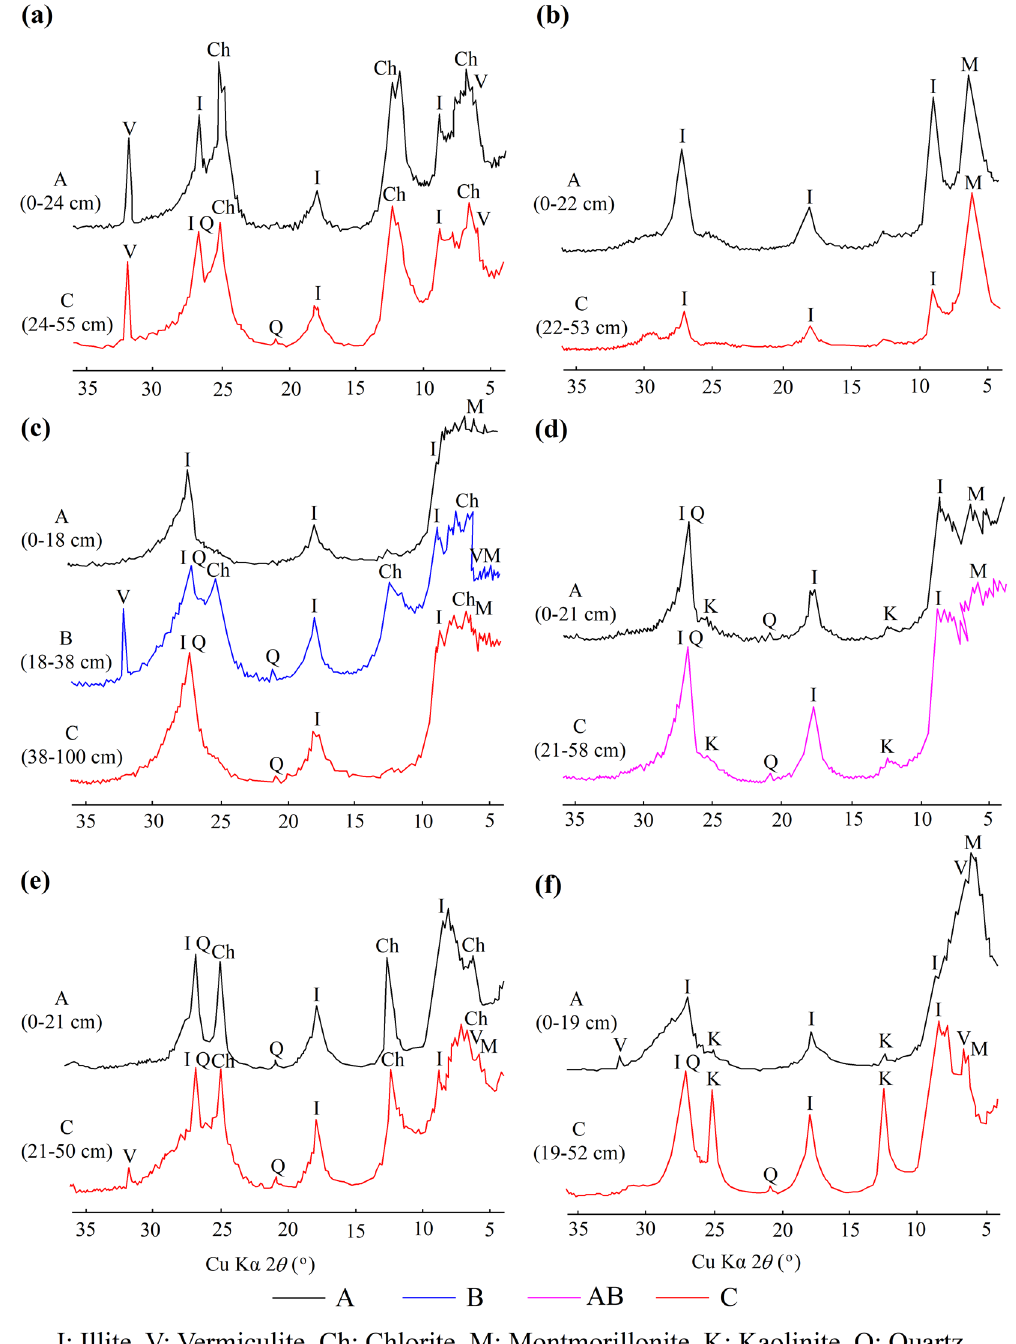
Figure 5. X-ray diffraction diagrams of the clay fractions in the purple soils developed from the rocks of K 2 j ( a ), little quartz (2 θ at 20.90°, 26.65°) and with or without kaolinite (2 θ at 12.38°, 24.93°) because of their low degree of weathering. There is some clay mineralogical similarity between the clay-sized fraction in the purple rocks and the clay-sized fraction in the overlying purple soils (Fig. 5). The clay fractions in the red purple soils developed from the rocks of the Cretaceous Jiaguan Formation(K 2 j ) and in Chengqiangyan Group (K 1 c ) are dominated by chlorite (2 θ at 6.22°, 12.38°, 25.01°), vermiculite (2 θ at 6.14°, 31.84°) and illite (2 θ at 8.84°, 17.73°, 26.76°) and by montmorillonite (2 θ at 5.85°) and illite (2 θ at 8.84°, 17.73°, 26.76°), respectively (Fig. 5(a,b)). The calcareous purple soils overlying the thick purplish red mudstone and purplish red sandstone of the Jurassic Penglaizhen Formation (J 3 p ) and Suining Formation (J 3 s ) are characterized by montmorillonite (2 θ at 5.70°~5.85°), chlorite (2 θ at 6.22°, 12.38°, 25.01°) and illite (2 θ at 8.84°, 17.73°, 26.76°) and by montmorillonite (2 θ at 5.70°~5.85°) and (2019) 9:13272 | https://doi.org/10.1038/s41598-019-49687-9